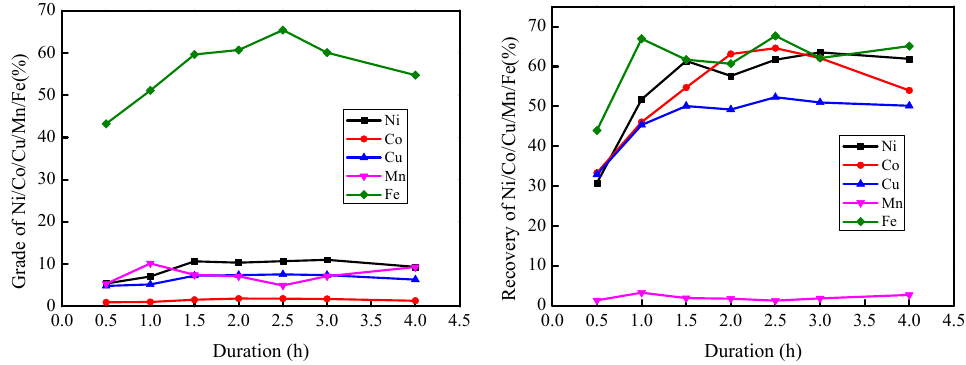
ff ect of reaction duration on the concentration of valuable Figure 7. Effect of reaction duration on the concentration of valuable metals. Figure 7. E Figure 7. Effect of reaction duration on the concentration of valuable metals.